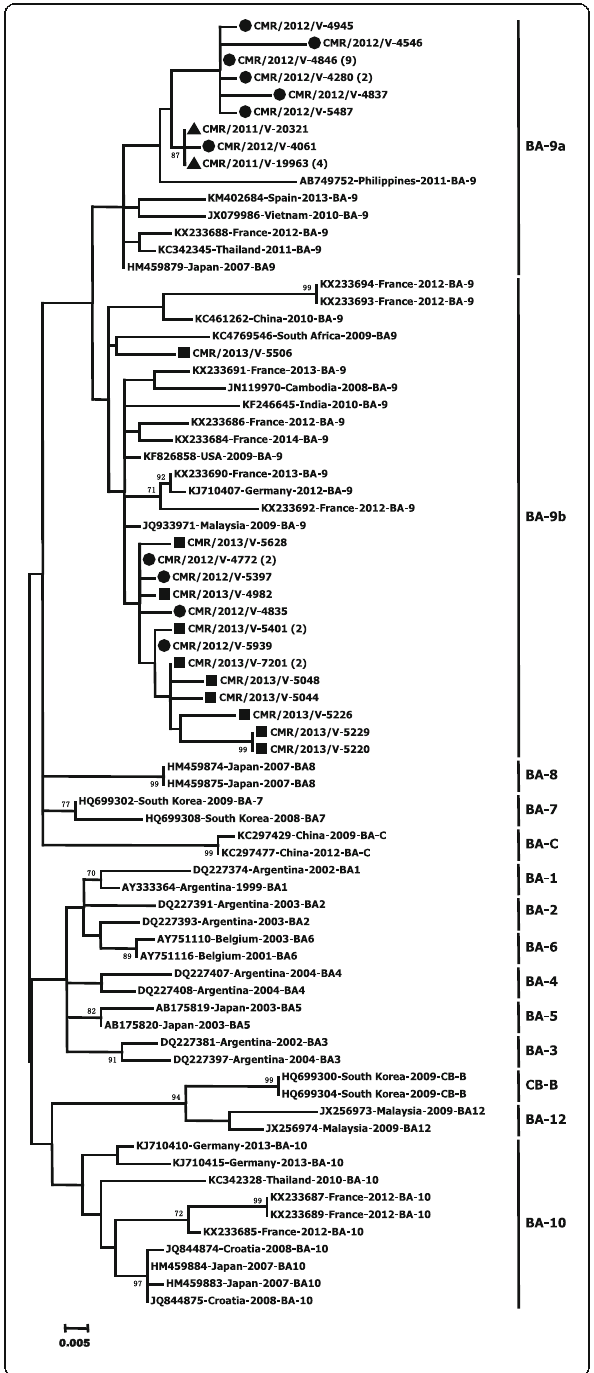
Fig. 2 Phylogenetic trees of HRSV-B strains detected in Cameroon from 2011 to 2013. Multiple sequence alignment was performed with Clustal W. The unrooted trees were generated based on nucleotide sequences of the C-terminal HVR2 region of the G gene using the maximum likelihood method under the Tamura-Nei model with the site heterogeneity gamma model in MEGA version 6. The scale bars represent the frequency of nucleotide substitutions, and the numbers at the nodes of the branches are the values determined for the bootstrap resampling after 1000 iterations. Only bootstrap values >70% are represented. The reference sequences from different continents, obtained from GenBank, are identified from left to right with accession numbers, countries, years of virus collection, and genotypes. Current study strains are identified from left to right by CMR (Cameroon), the year of detection, and the laboratory number. The sequences of Cameroon are marked with triangle, circle, and square for the year 2011, 2012, and 2013, respectively. The groups/genotypes assigned to branches are at the right after the bars